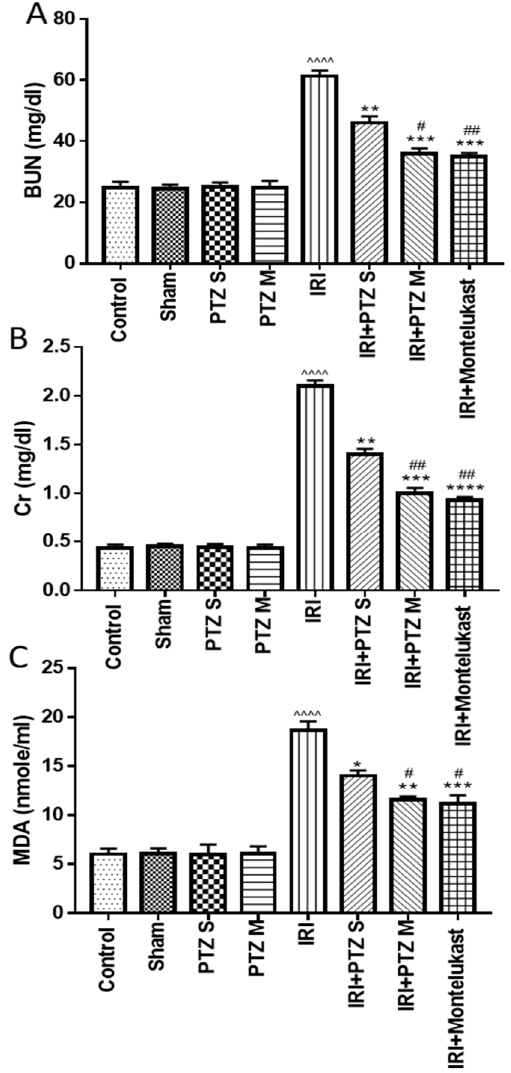
Figure 1. Effect of various treatments on serum levels of BUN ( A ), Scr ( B ), and MDA ( C ). Bars represent mean ± SEM. Significant difference between groups is analyzed by Student’s t -test after one-way ANOVA test ( n = 8), where: ˆˆˆˆ: p < 0.0001, compared to normal control group. *: p < 0.05, **: p < 0.01, ***: p < 0.001, and ****: p < 0.0001, compared to IRI group. #: p < 0.05, ##: p < 0.01, compared to (IRI + PTZ S) group.